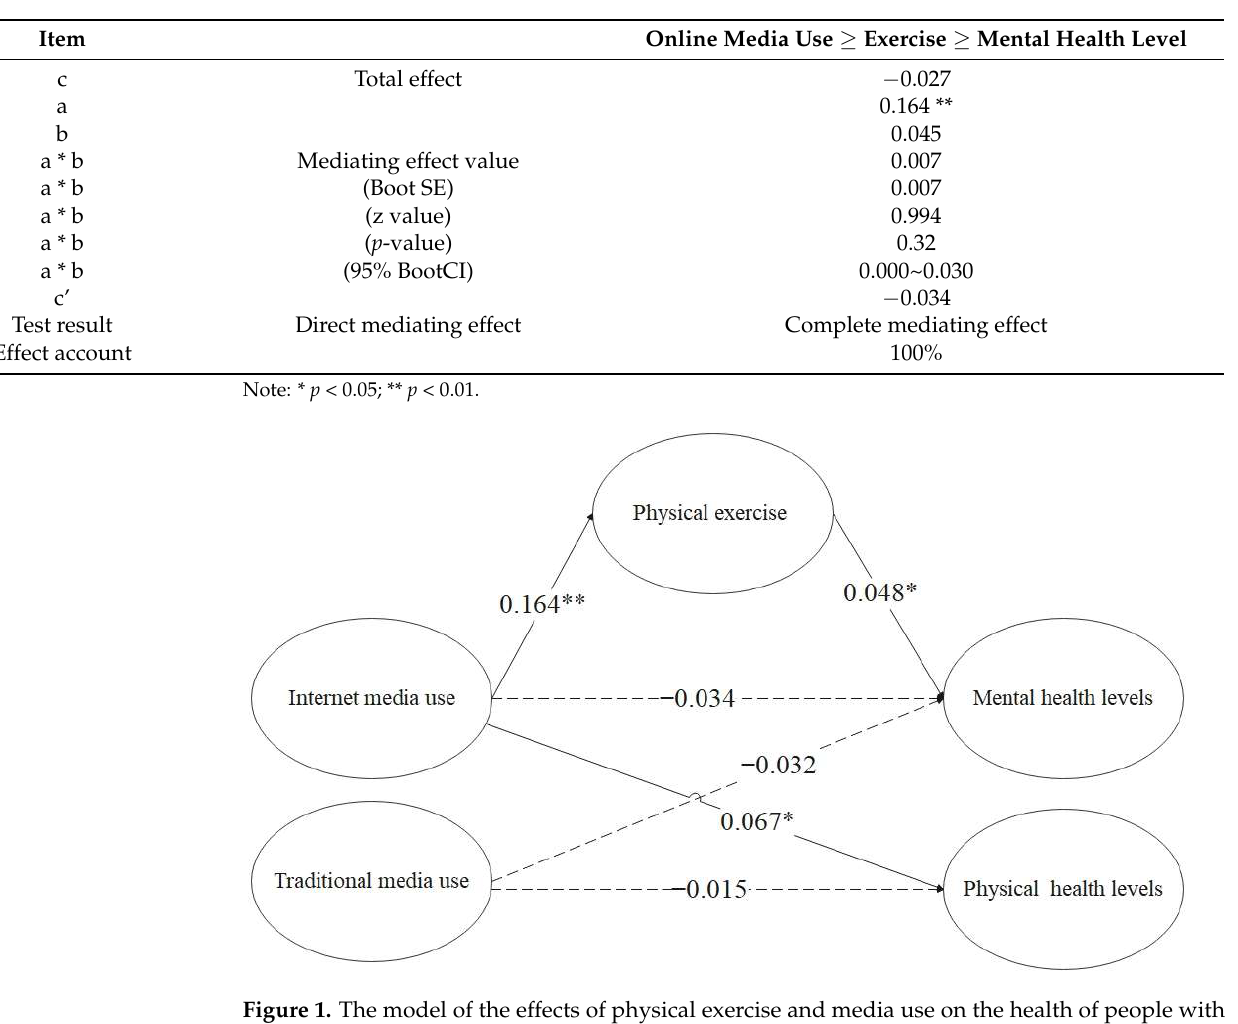
Table 9. Results of Mediating effects.